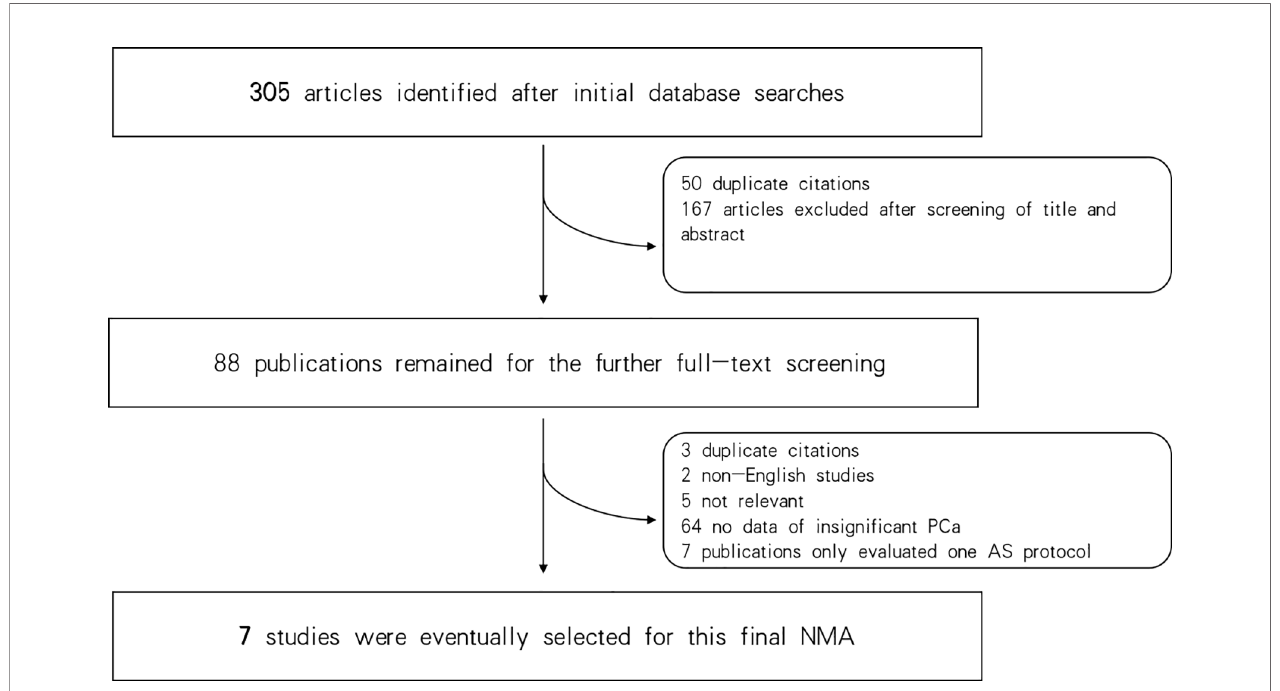
FIGURE 1 | Flowchart of the study selection process and